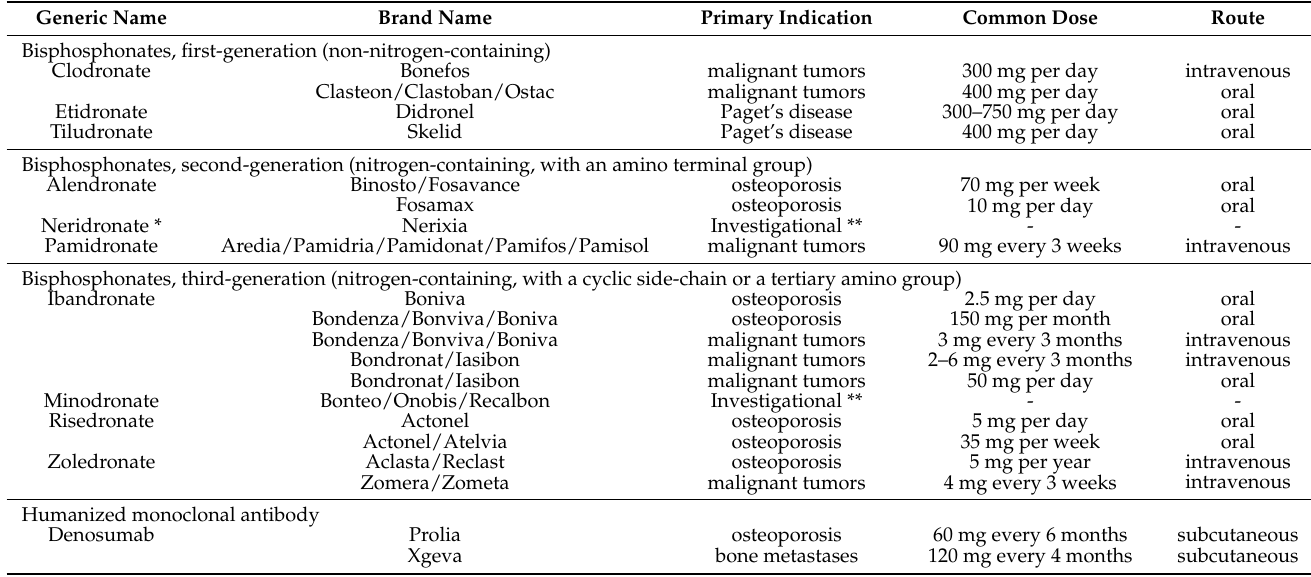
Table 1. Antiresorptive drugs, potential to cause